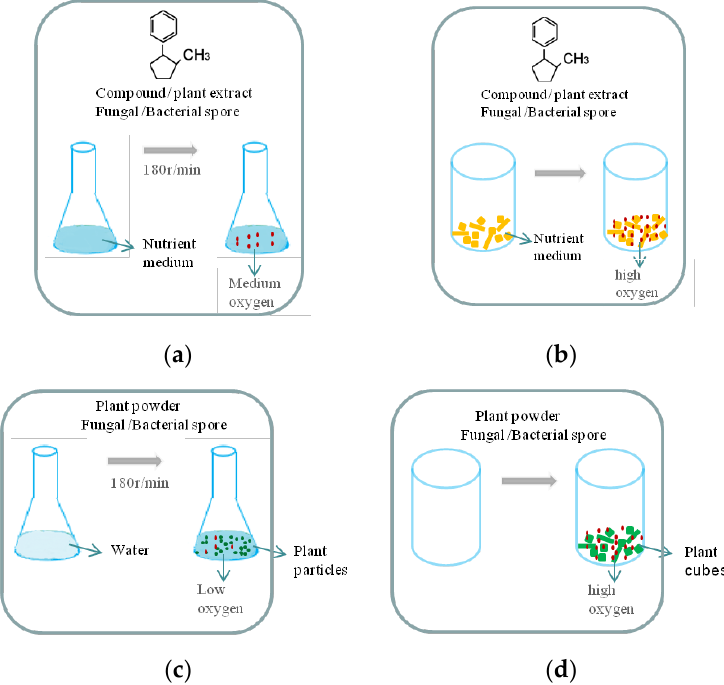
Figure 2. Schematic diagram of fermentation method: ( a ) Liquid fermentation: Nutrient medium (LB, TSB, PDB, etc.) added with compound/plant extract and fungal/bacterial spore at 180 r·min −1 . ( b ) Liquid fermentation: Water added with plant powder and fungal/bacterial spore at 180 r·min −1 . ( c ) Solid state fermentation: Nutrient medium (wheat bran, potato cubes, etc.) added with com- pound/plant extract and fungal/bacterial spore. ( d ) Solid state fermentation: Plant cubes added with compound/plant extract and fungal/bacterial spore.